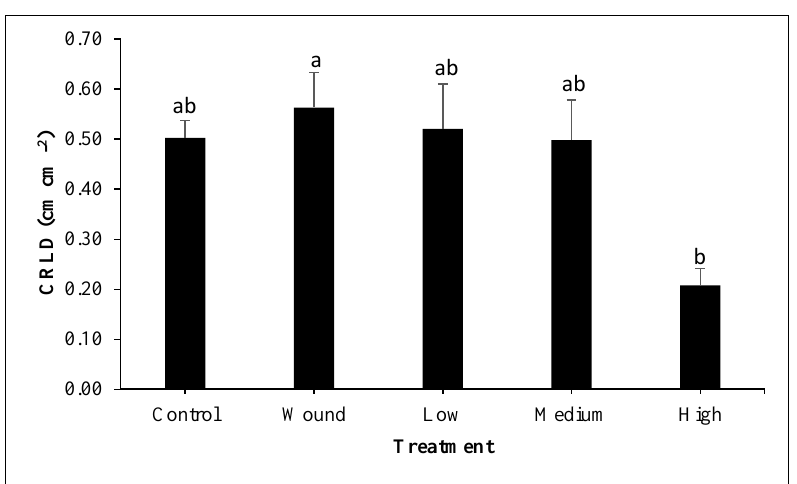
Figure 5. Cumulative root length density (CRLD) in October 2019 at the 0 to 50 cm soil depth 31 months following stem inoculation of P. taeda trees with L. terebrantis. Means associated with different lowercase letters are significantly different at an α -level of 0.05 by the Tukey HSD test for multiple comparisons. Bars represent one standard error of the mean.